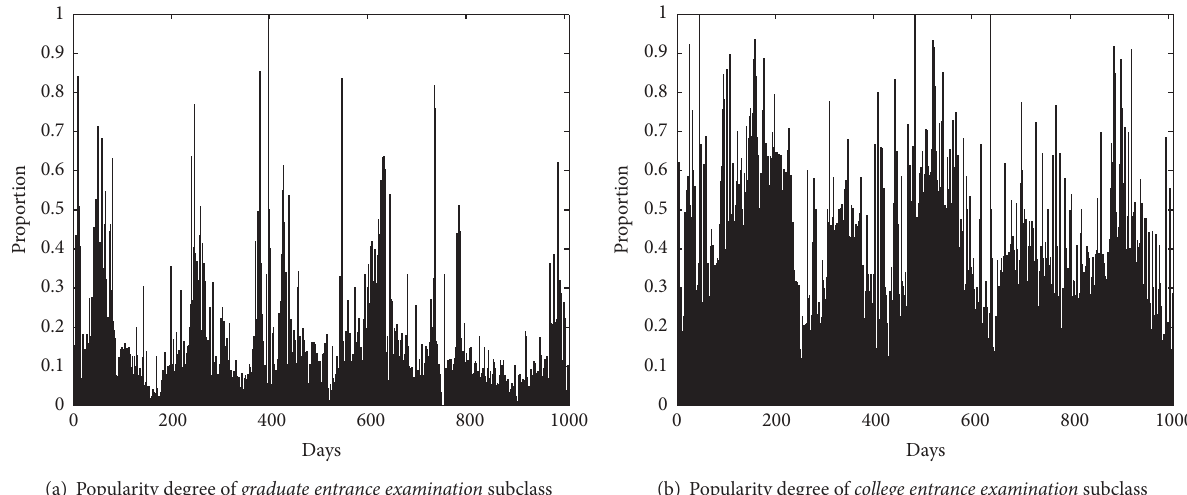
Figure 4: Periodic subclass news distribution. Remark. 𝑥 - axis denotes the date from August 1, 2009, to May 3, 2012; 𝑦 -axis denotes the value of 𝐻 𝑘 in